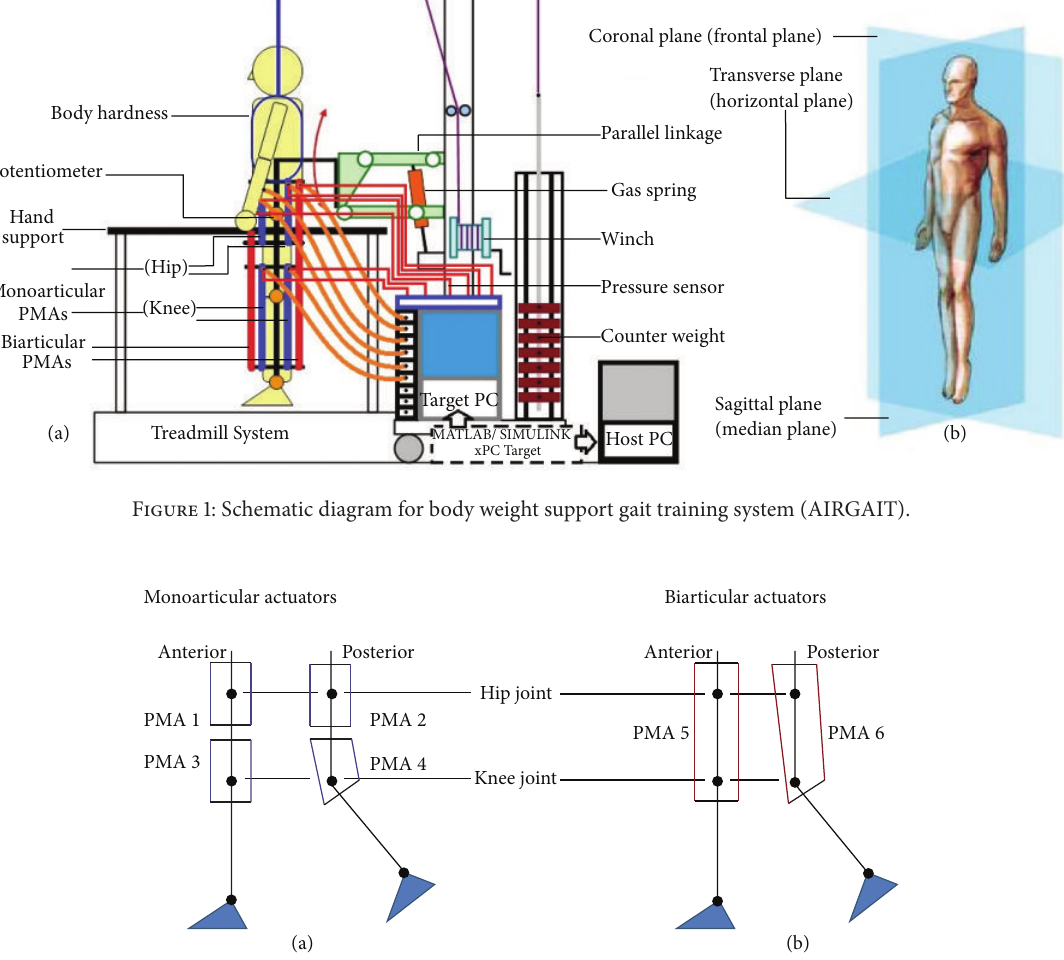
Figure 2: PMAs’ setting; (a) antagonistic mono-articular (hip and knee joints) actuators and (b) bi-articular